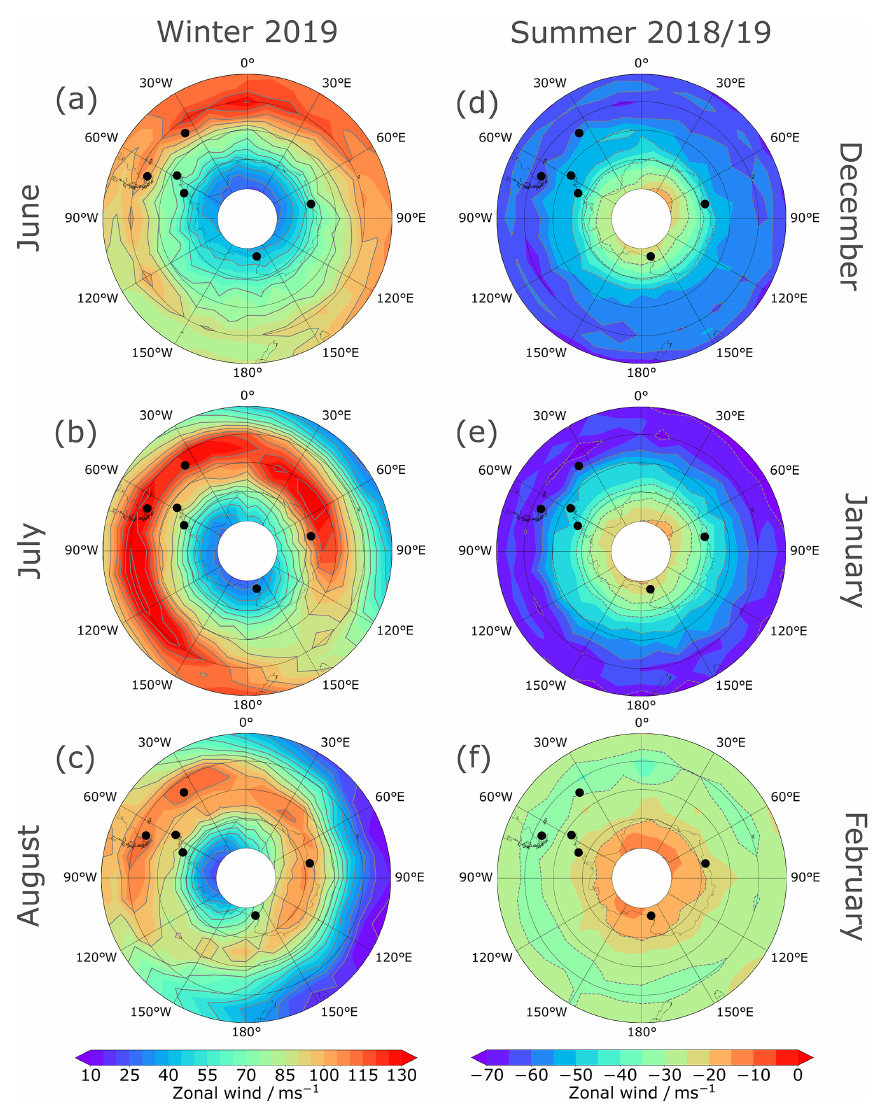
Figure 10. Monthly mean geostrophic zonal wind for the austral winter 2019 (a, b, c) and summer 2018/2019 (d, e, f) , each averaged over the altitude range of its wind maximum (40–60km for winter, 60–80km for summer). Black dots mark the positions of the radar stations used here. Data are derived from MLS geopotential height